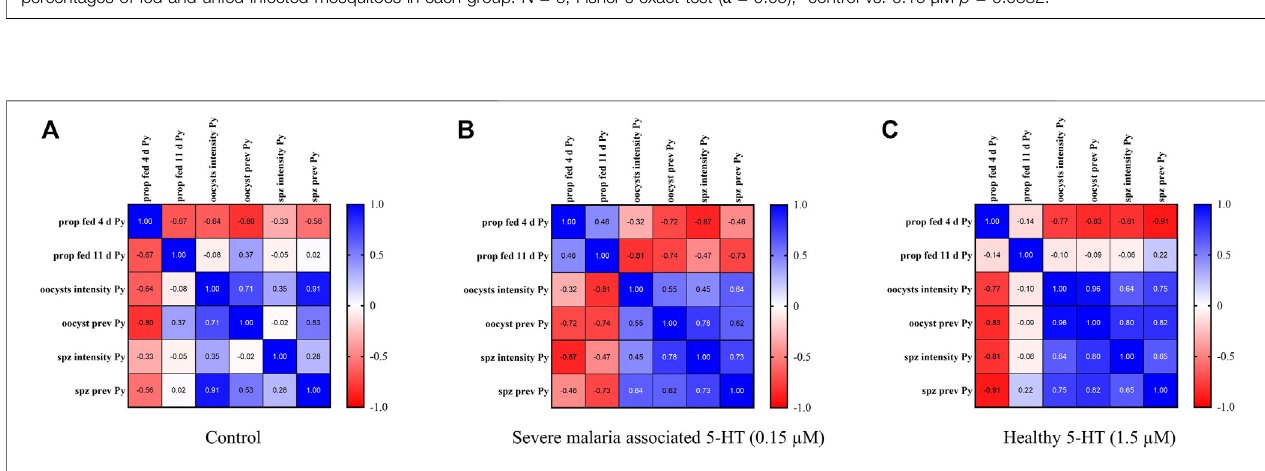
Frontiers in Physiology |